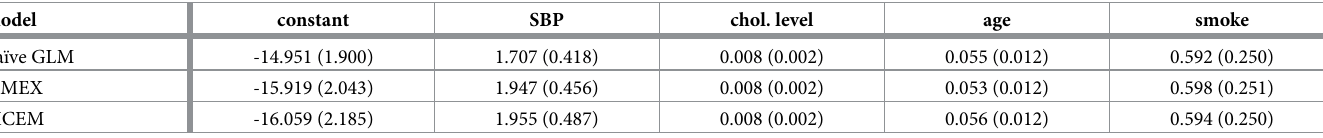
Table 1. Model coefficient estimates (standard errors in parenthesis) for each model fitted to the Farringham Heart Study.